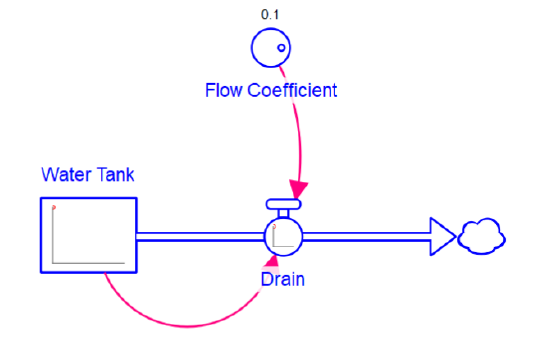
Fig. 12. Drainage stock-and-flow